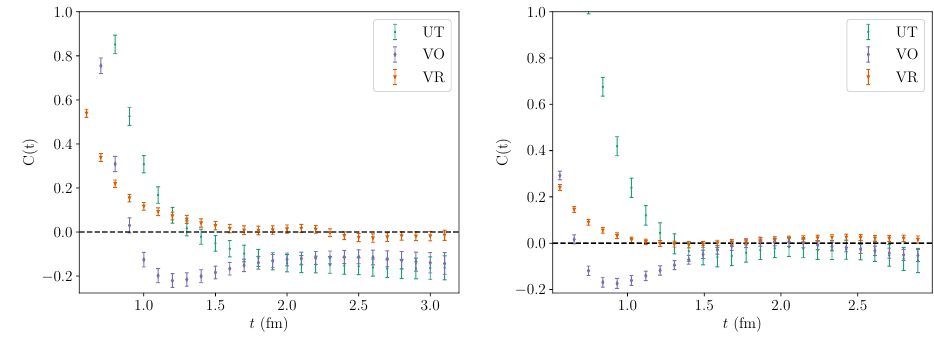
Figure 8. The pure-gauge Euclidean correlator (left) is compared with the m π = 156 MeV dynamical- fermion Euclidean correlator (right). Shown are the results from the untouched (UT), vortex-removed (VR) and vortex-only (VO) ensembles. A dashed line at C ( t ) = 0 is provided to aid in observing positivity